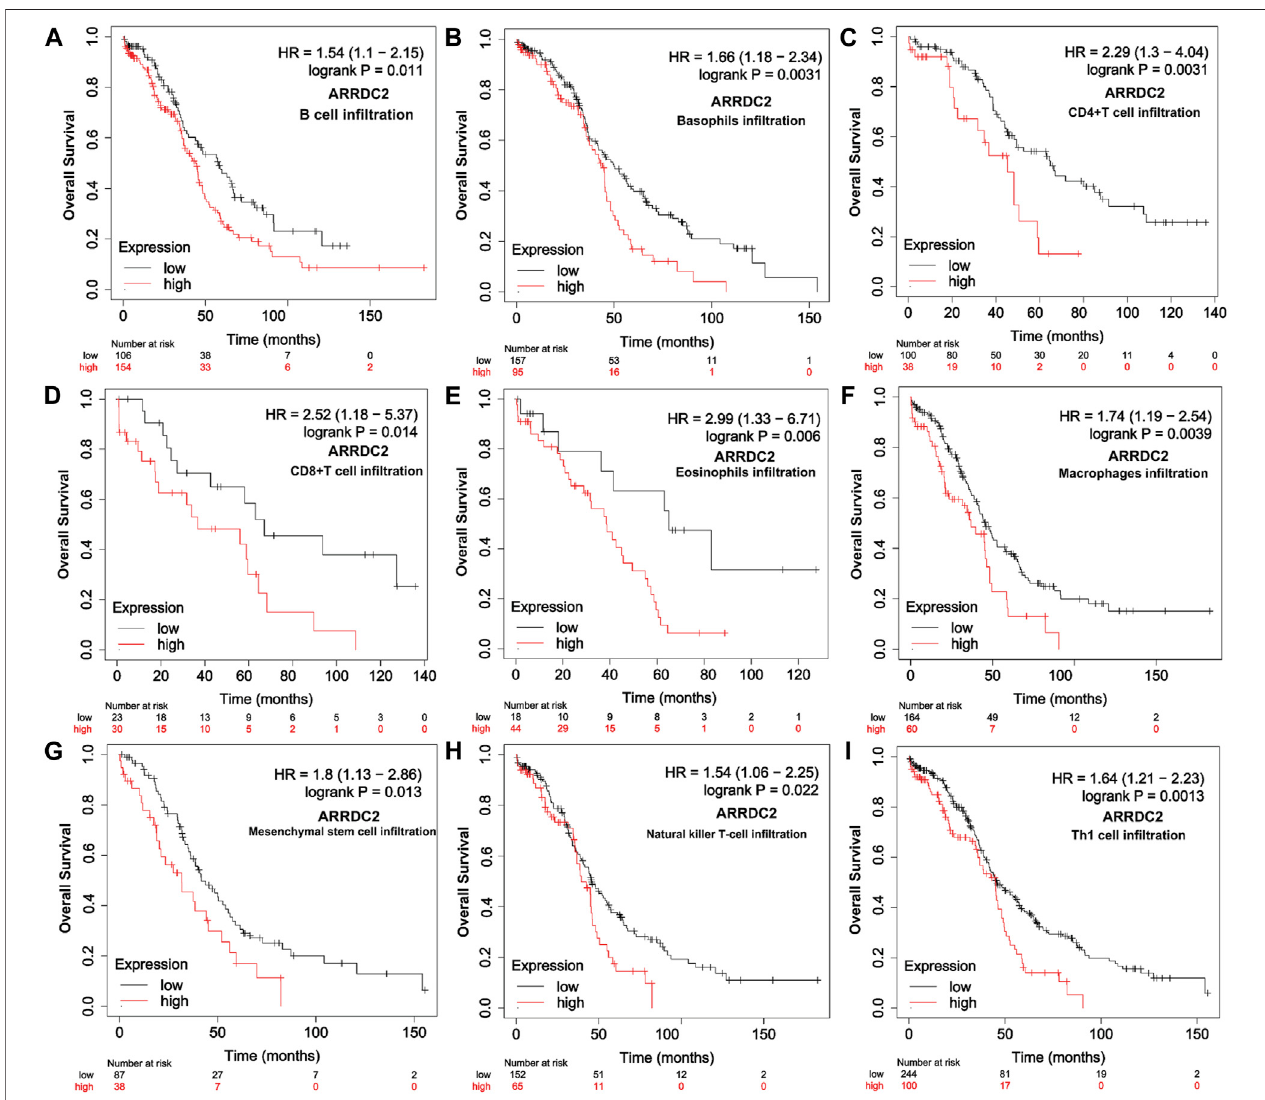
FIGURE 6 | Relationship between overall survival and immune cell in fi ltration and ARRDC2 gene expression in OV patients. (A) B Cell in fi ltration. (B) Basophils in fi ltration. (C) CD4+ TCellin fi ltration. (D) CD8+TCellin fi ltration. (E) Eosinophilsin fi ltration Neutrophil. (F) Macrophagein fi ltration. (G) Mesenchymalstemcellin fi ltration. (H) Natural killer T-cell in fi ltration. (I) Th1cell in fi